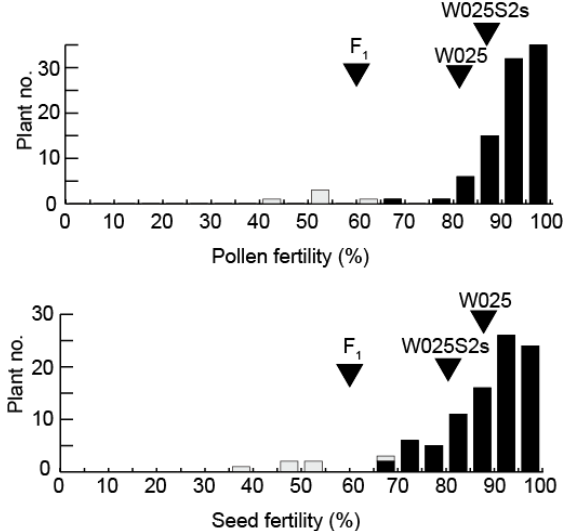
Figure 3. Pollen and seed fertility of F 2 plants derived from the cross between W025 and W025S2s observed in 2020. Black and white bars represent O. glaberrima homozygotes and heterozygotes, respectively. The genotype of each plant was determined using a DNA marker S2_4. The average pollen and seed fertilities of W025, W025S2s and their F1 hybrids are shown by arrow heads.